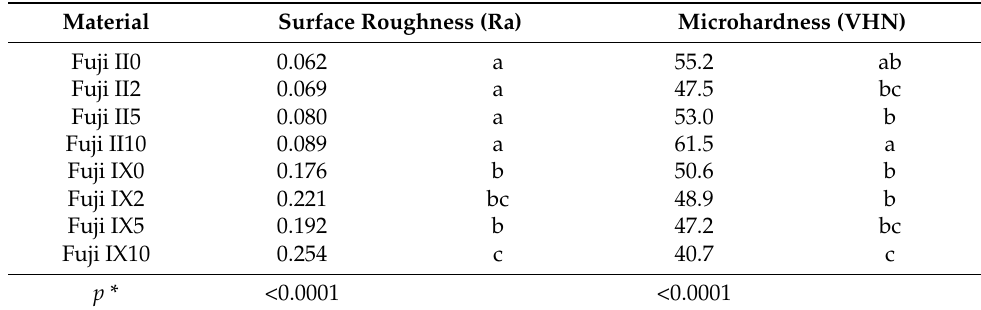
Table 2. Results of the ANOVA test for Fuji II and Fuji IX.